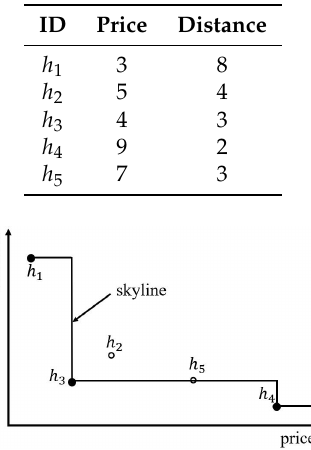
Table 1. A Hotel Example.